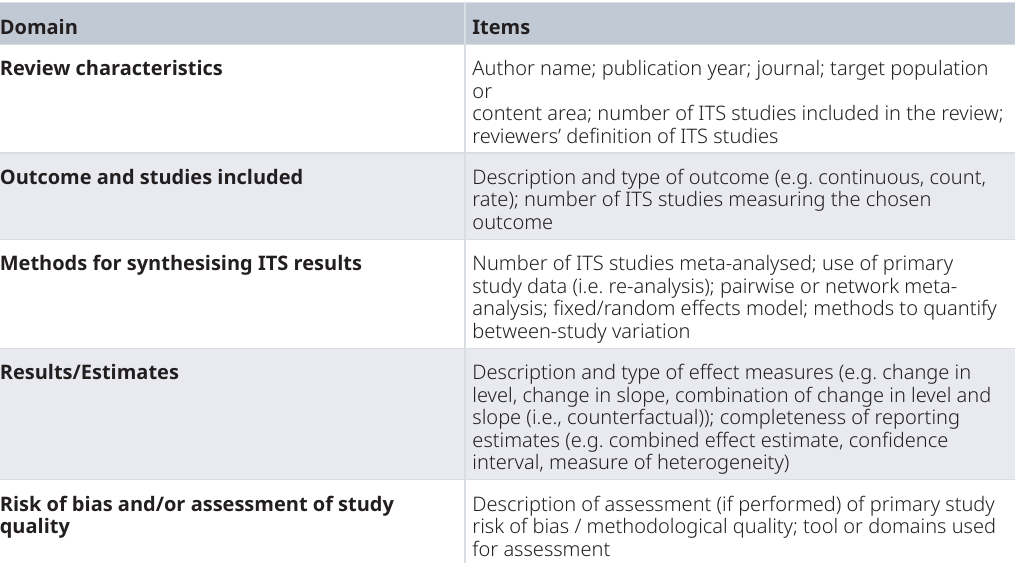
Table 2. Summary of data extraction items for the selected meta-analysis.